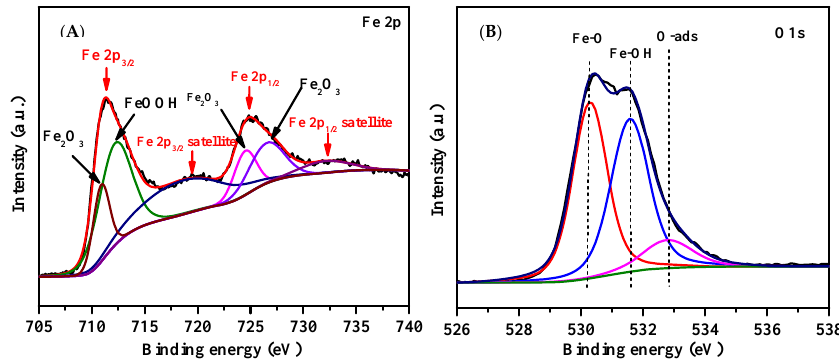
Figure 1. ( A ) Fe 2p XPS spectra of Fe@CC, and ( B ) O 1s XPS spectra of Fe@CC.